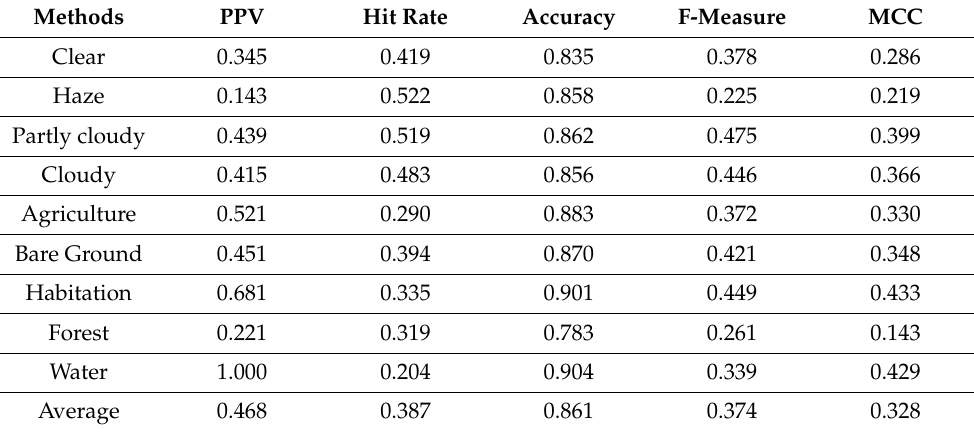
Table 2. Result analysis of CapsNet model with different measures.